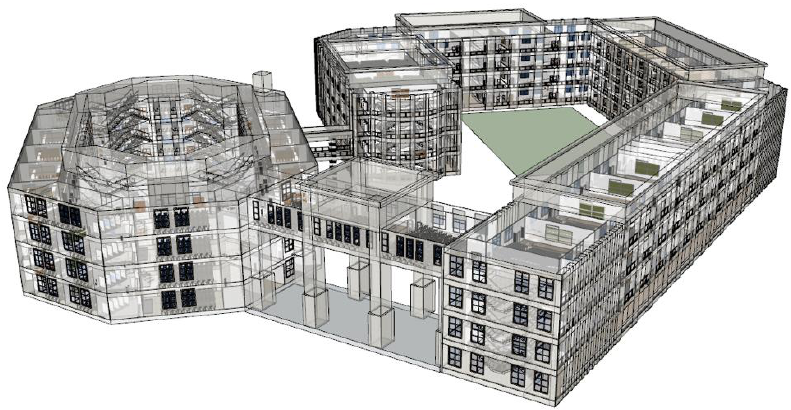
Figure 5. 3D building model.